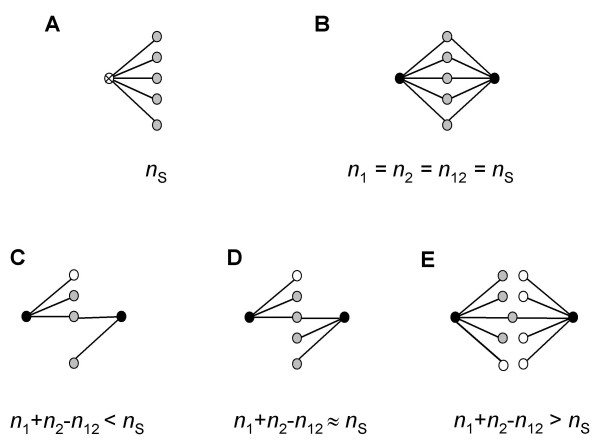
The schematic representation of duplicate gene evolution (A) prior to duplication event, (B) immediately after duplication, (C, D, E) after some time following gene duplication. The ancestral singleton gene is shown with a crossed line, duplicate genes are in black, shared ancestral partners are in grey, unique ancestral partners are in stripes, and unique acquired partners are in white; ns, n1 and n2 are the numbers of partners for a singleton, first duplicate, and second duplicate, respectively; n12 is the number of shared partners for a duplicate gene pair.